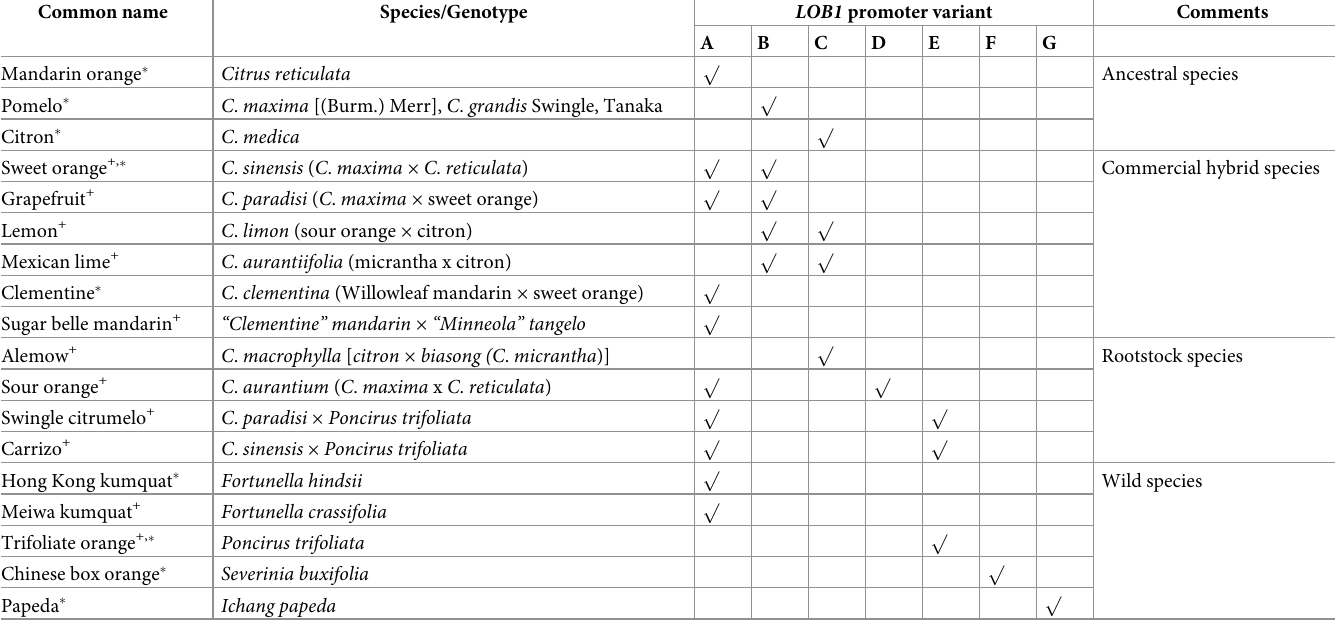
Table 2. Variants in the LOB1 promoter among Rutaceae